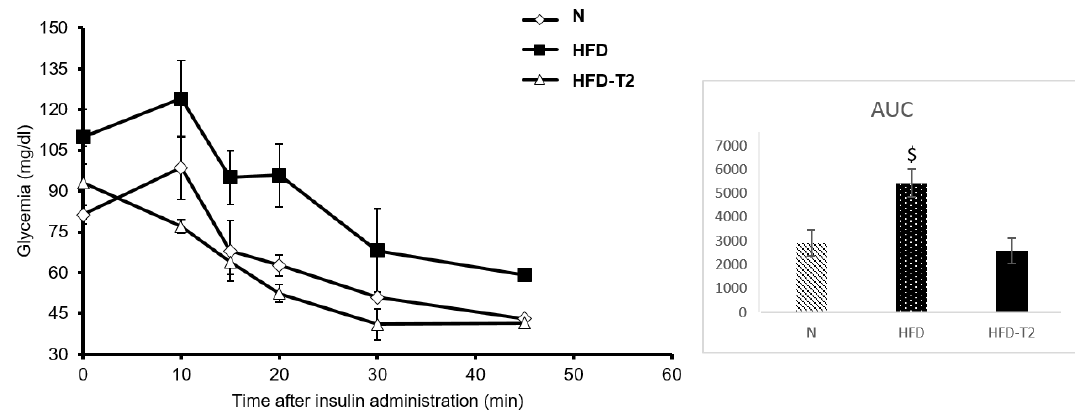
Figure 1. Insulin Tolerance test (ITT). Glycemia after insulin administration at different time points in N, HFD, and HFD + T 2 rats. Area under the curve (AUC). Values are means ± SEM of five independent experiments ( N = 5) $ p < 0.05 vs. N and HFD-T 2 . After 10 min from insulin injection, both N and